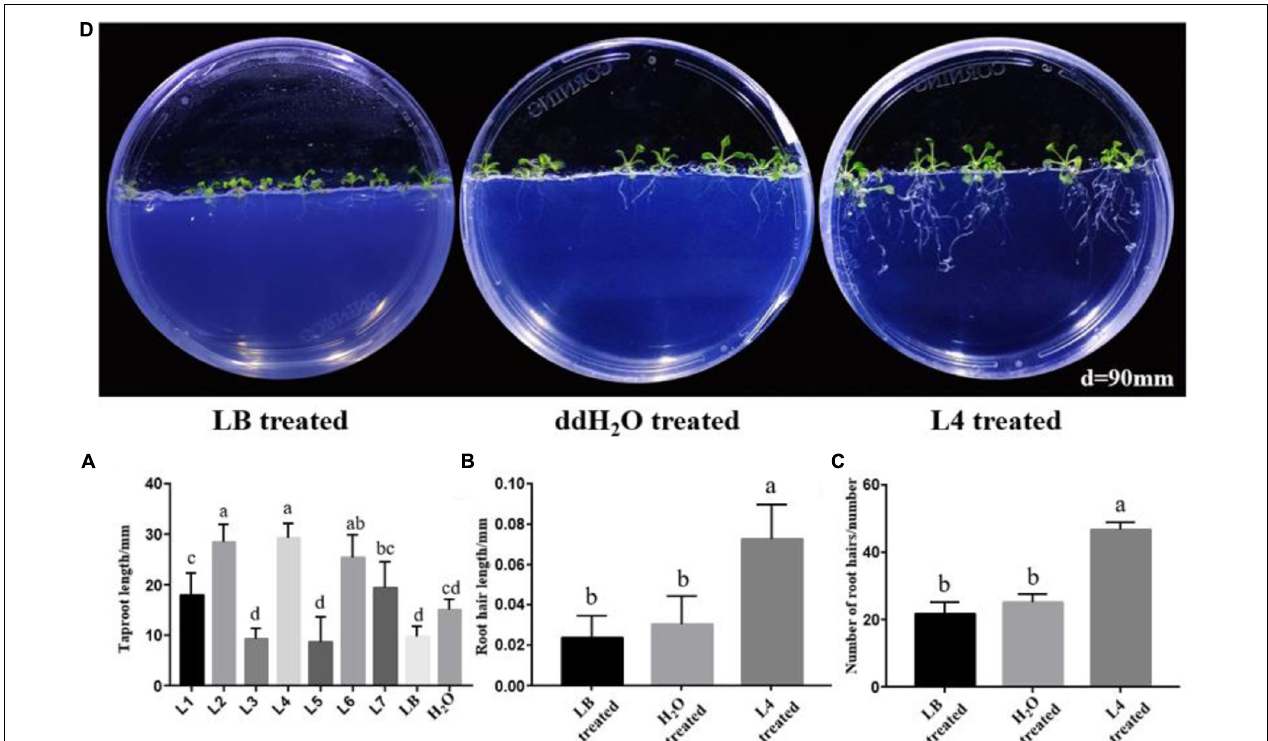
FIGURE 3 | Root morphology influenced by the colonization of PGPR isolates. (A) The growth of Arabidopsis thaliana treated with S . lincolnensis L4; (B) changes in taproot length of A . thaliana after colonization by strain Streptomyces wuyuanensis L1, Streptomyces cinereoruber L2, Streptomyces palmae L3, S . lincolnensis L4, Streptomyces wuyuanensis L5, Streptomyces pactum L6, and Streptomyces zaomyceticus L7. It can be seen from the figure that L4 strain has the best effect on promoting the root length; (C) changes in root hair length after treatment by S . lincolnensis L4; (D) changes in number of root hairs per 3 mm taproot after treatment by S . lincolnensis